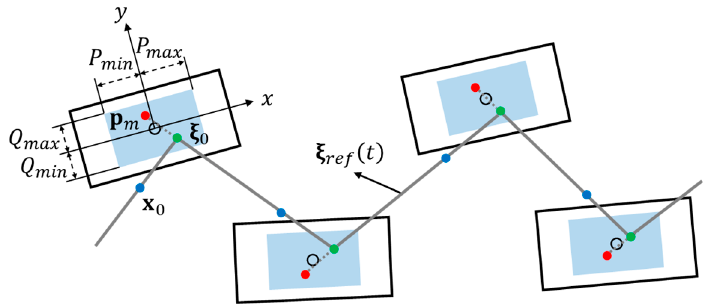
Figure 3. Reference capture point (CP) trajectory generation using ZMP manipulation.